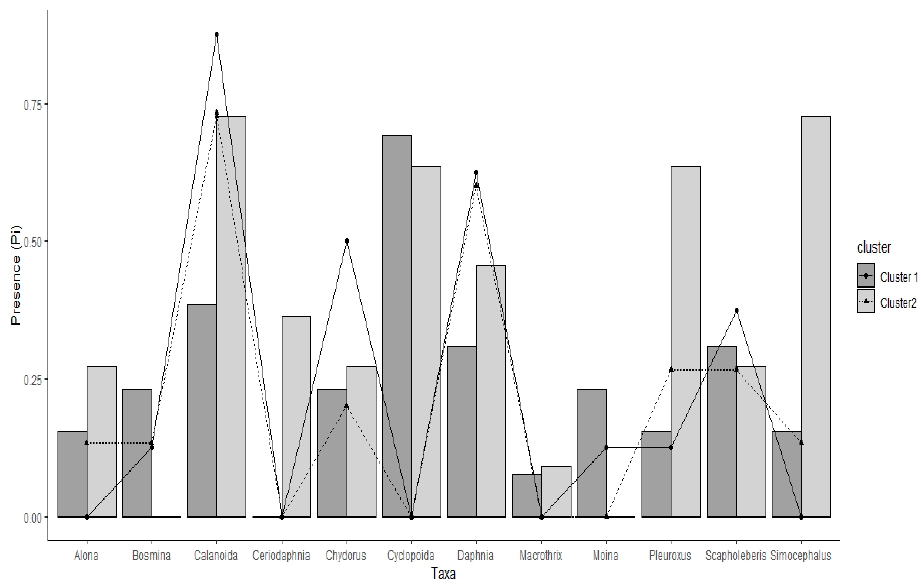
Figure 5. The barplot was relative to the years 2014, each value of the taxa presence (Pi) was relative to a particular cluster, reported in different colors (dark grey for Cluster 1 and light grey for Cluster 2). The lines and points showed the values of taxa presence (Pi) for the year 2015, where each cluster was reported with different shape of points and line types (circle with continuous line for Cluster 1 and triangle with dotted line for Cluster 2).